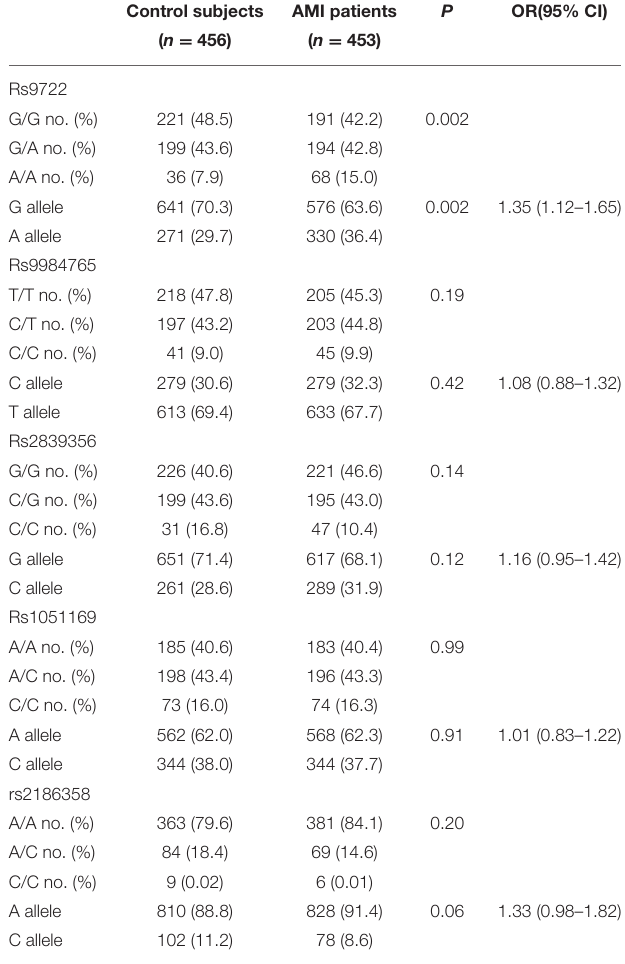
TABLE 3 | Genotypic and allelic frequencies of S100B polymorphisms between the 456 control subjects and 453 AMI subjects. Control subjects AMI